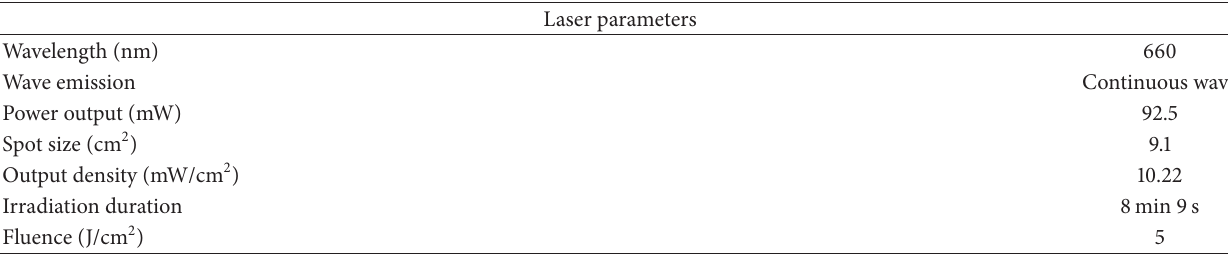
Table 1: Laser parameters.